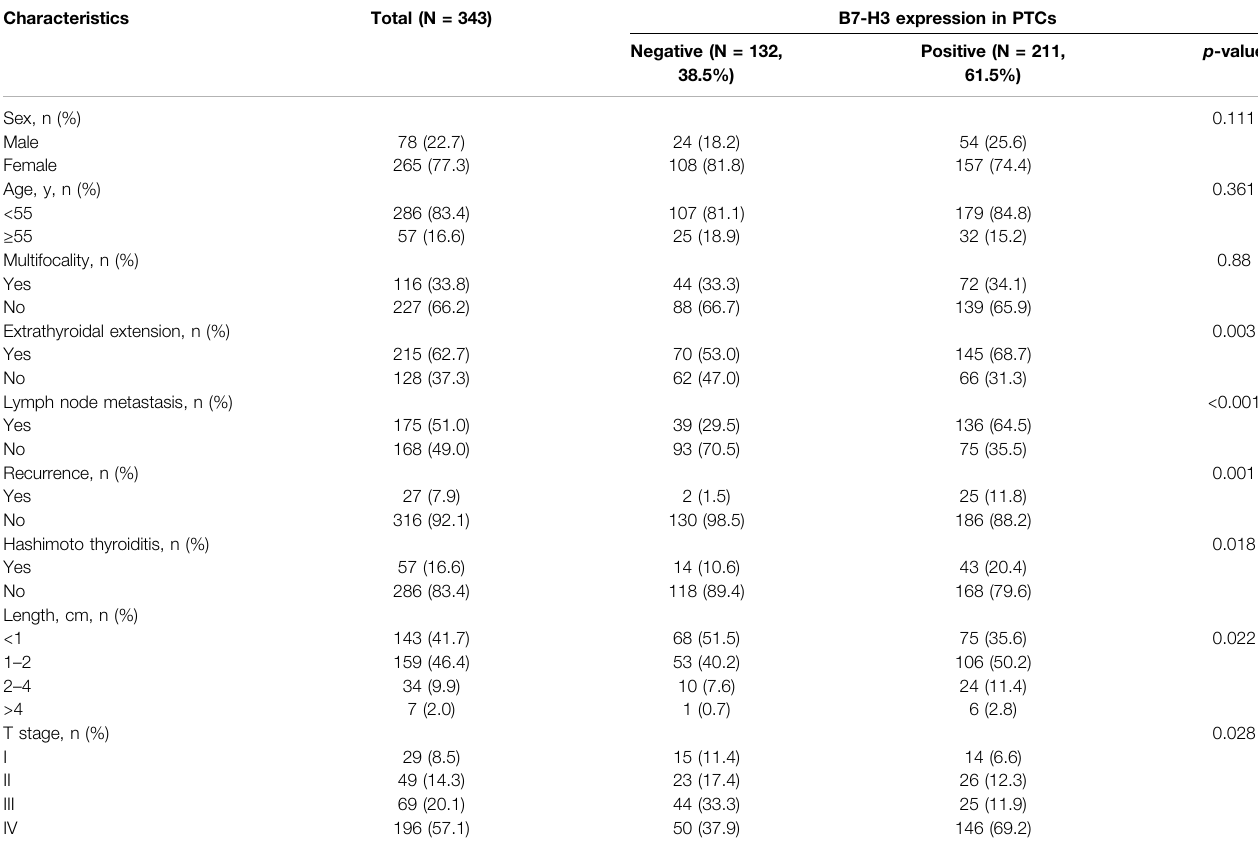
TABLE 1 | Relationship of B7-H3 expression by clinicopathological factors in PTC.